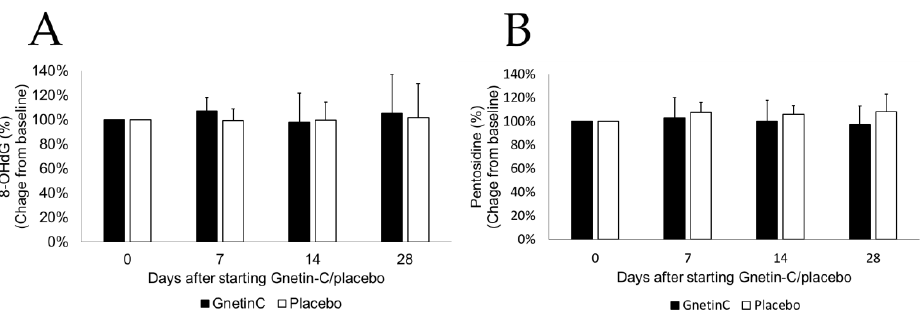
Figure 8. The effects of Gnetin-C on 8-Oxo-2′-deoxyguanosine and pentosidine. ( A ) 8-Oxo-2′-deoxyguanosine and ( B ) pentosidine before and after the intervention in Gnetin-C and placebo groups.